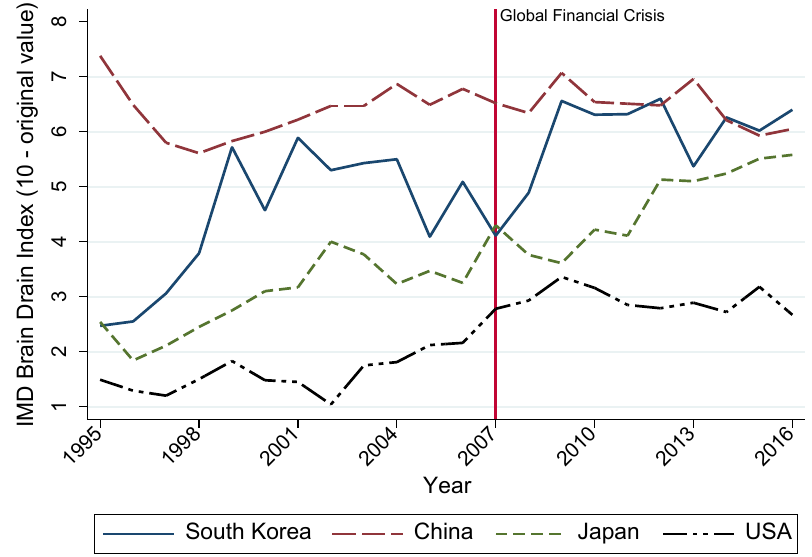
Figure 1. Time series of IMD brain drain index of South Korea, China, Japan, and U.S.A. Source: IMD